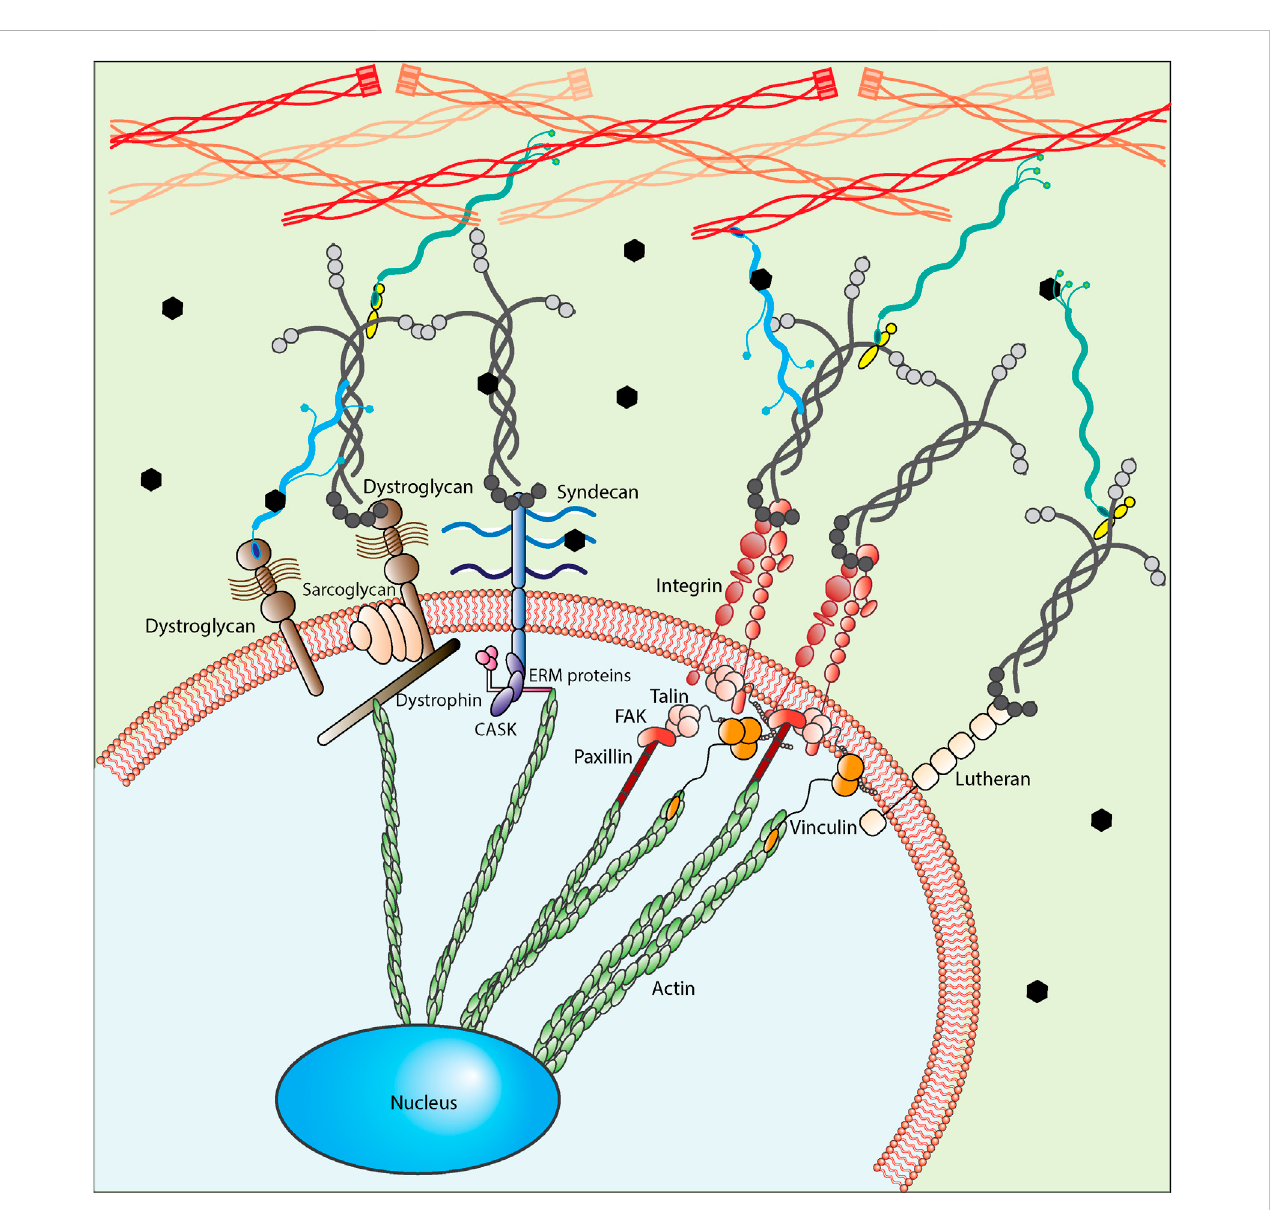
A close up of cell-ECM interaction. Neural stem cells interact with their microenvironment using different types of receptors including non-integrin lamininreceptors(Dystroglycan,SyndecanandLutheran)andintegrins.AphysicallinkbetweencellsandECMproteinsexists,utilizingintegrinornon-integrin receptors based on the biochemical nature of the microenvironment. These interactions can be further classi fi ed as nascent adhesions and focal adhesions and further allow cells to distinguish the structural components of the microenvironment through their bonds or interaction points. For integrin- mediated interactions, the fi rst step is called integrin activation, through which integrins go from a bent-closed conformation with low-af fi nity ligand binding to an extended conformation with high-af fi nity ligand binding. After forming the bond between integrins and their ligands, talin binds to integrin cytoplasmic tail promoting integrin activation. Upon integrin activation, integrins form clusters adhering to the ligands. They then recruit adaptor proteins (e.g., vinculin, FAK, and paxillin) facilitating the formation of a signaling complex at the cytoplasmic tails and the formation of the nascent adhesion accordingly. These nascent adhesions are transient force-independent structures whose formation does not rely on myosin-II activity. Finally, through the third step, the adhesions are mostly disassembled, but a few of them persist, associate with actin fi laments polymerized at the leading edges and develop into focal adhesions, which are force-dependent. FAs are highly dynamic structures that are stable compared to NAs and require further integrin clustering. For dystroglycan-mediatedinteractions,thesarcoglycansformacomplexofmembraneproteinsanddystrophinwiththedystroglycancomplex.Dystrophinthen binds to actin cytoskeleton to provide the link between the extracellular matrix and cytoskeleton and fi nally nucleus. For syndecan-mediated interactions, it links to actin cytoskeleton using CASK and ERM (ezrin, radixin and moesin) proteins. For Lutheran-mediated interactions, the cytoplasmic domain interacts with spectrin-based cytoskeleton, not actin